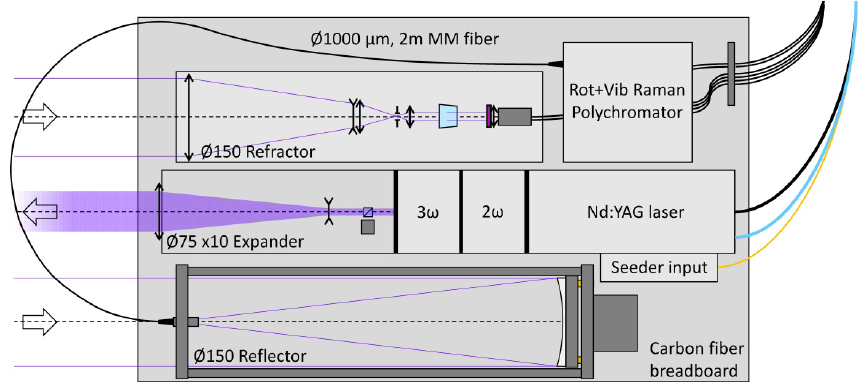
Figure 2. Global diagram of the lidar system. The main sub-systems are the emitter (center), the elastic receiver using a refractor (top), the Raman receiver using a fibered parabolic reflector (bottom), and a separate, thermally stabilized polychromator (upper right). See Fig. 5 for the detail of the polychromator design.